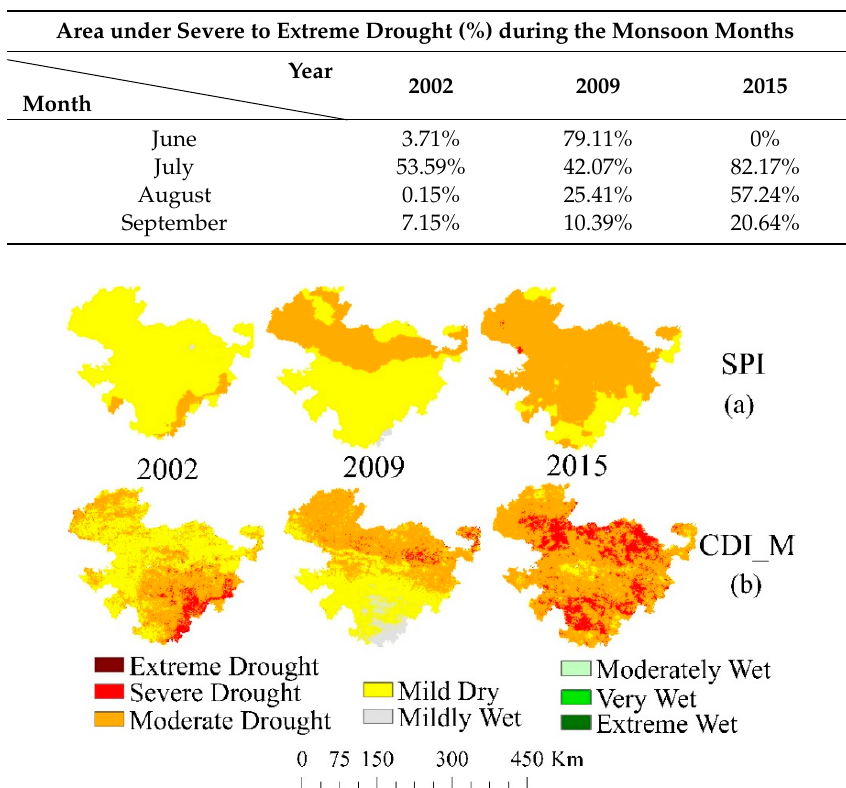
Table 4. Drought affected area during the primary drought years . Table 4. Drought a ff ected area during the primary drought years.